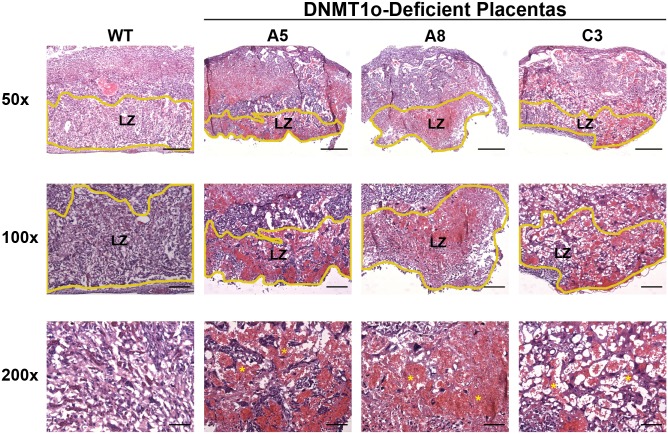
Histology of hematoxylin and eosin (H&E) stained labyrinth of one wild-type (wt) three DNMT1o-deficient low-Peg10 gDMD methylation placentas.The scale bars for 50X, 100X and 200X magnification are 500, 200 and 100 μm respectively. Yellow lines in 50x and 100x magnification images outline the labyrinthine zone (LZ).